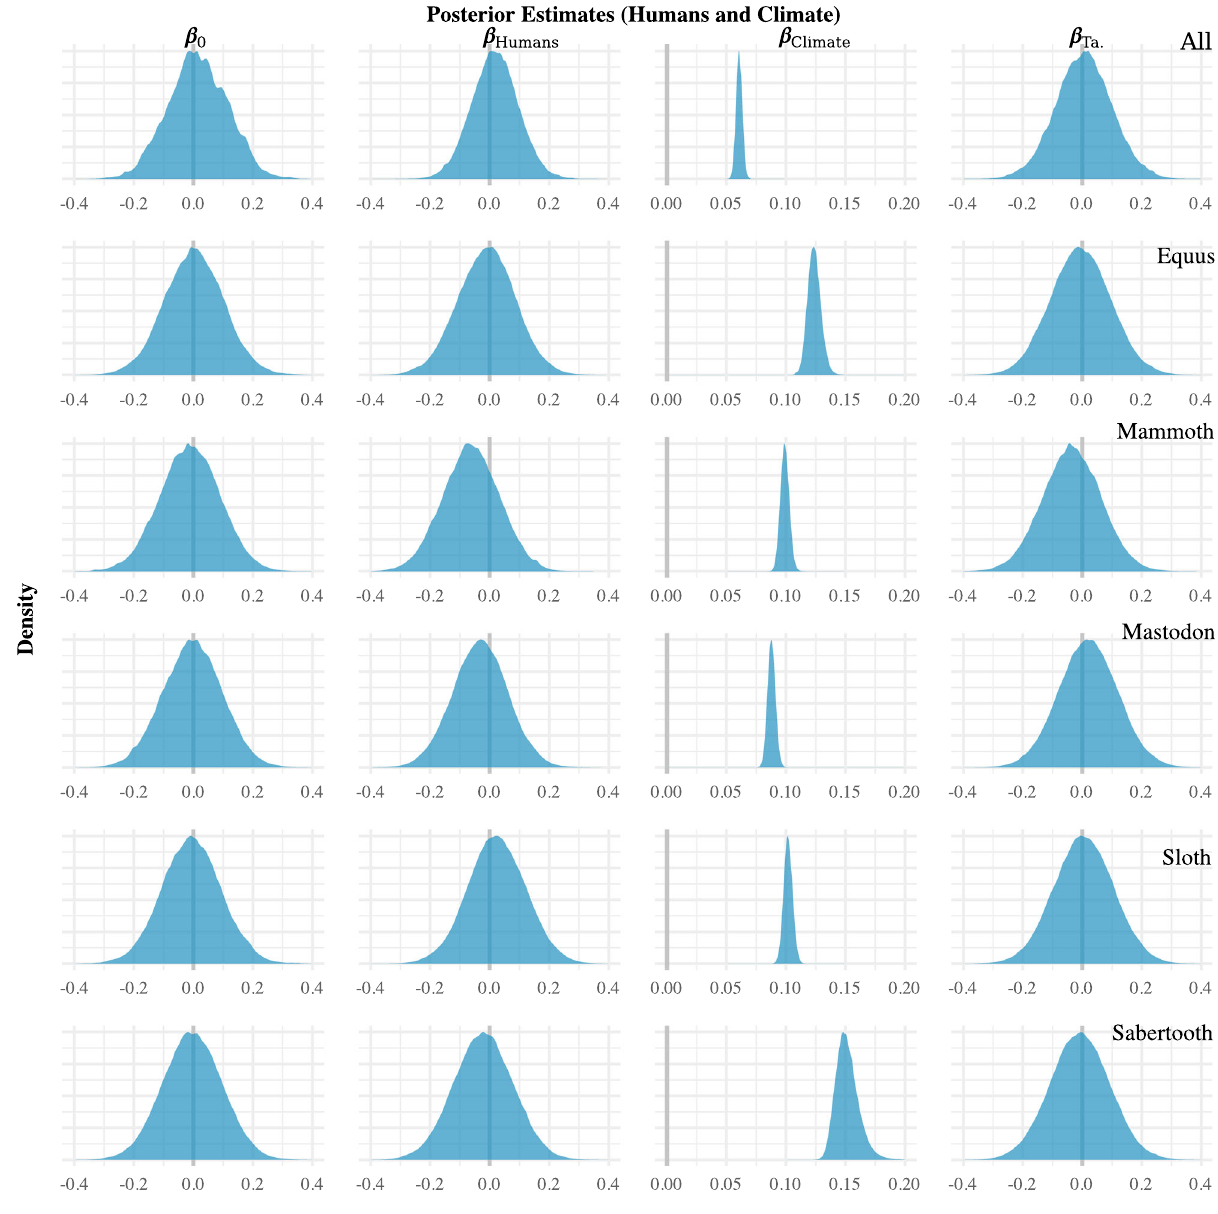
Fig. 4 Regression results for the mixed human and climate models. Note that for humans ( β Humans ) the estimates are centred on zero, whereas for climate ( β Climate ) the estimates do not overlap zero (denoted by the vertical grey